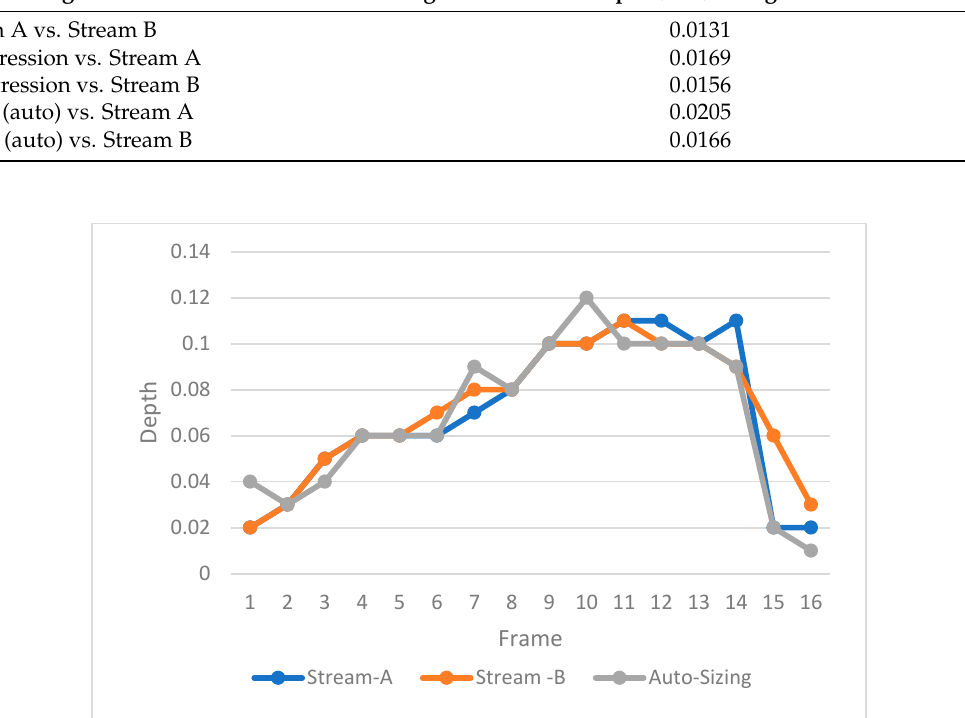
Figure 7. A sample for the auto sizing of one IND with 16 A-Scans.